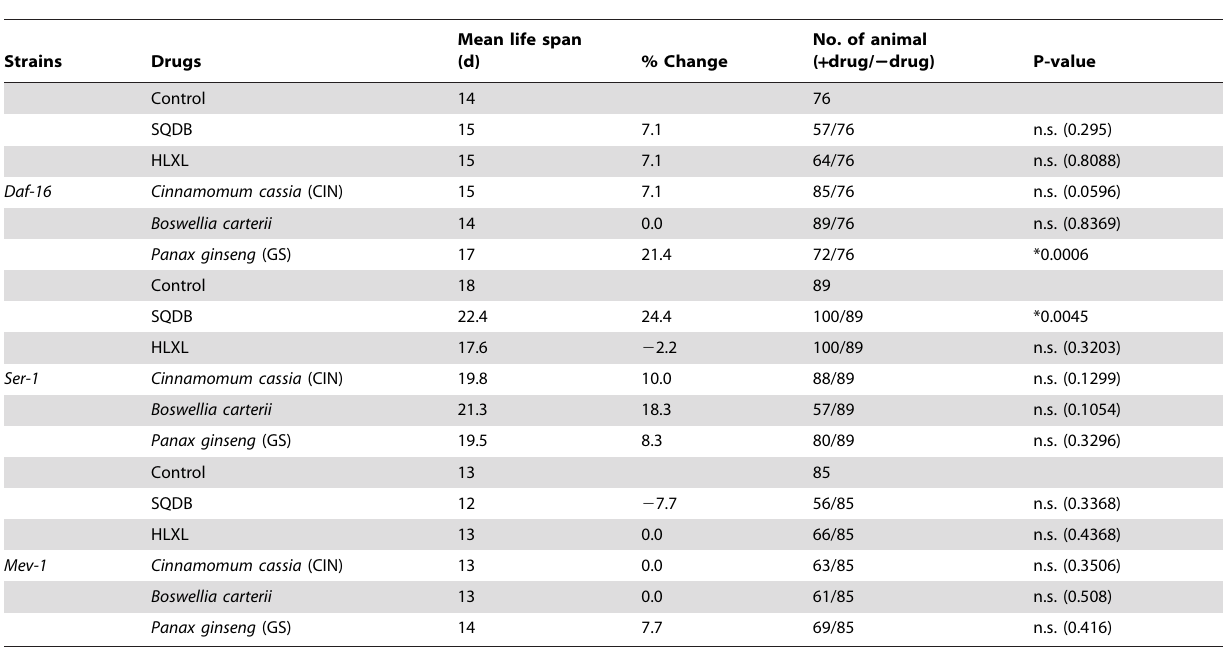
Table 5. Life span assays in mutant C. elegans fed with SQDB and individual herbs.